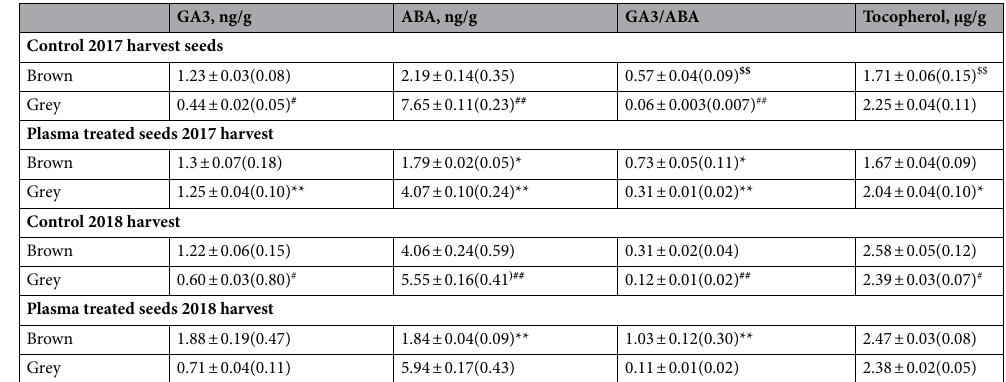
Table 1. The amount of GA3, ABA, GA3/ABA, and γ-tocopherol in control and plasma treated brown and grey radish sprout seeds harvested in 2017 and 2018. Results are presented as means ± SEM(SD), n = 6. *Statistically significant effect of CP (p < 0.05). **Statistically significant effect of plasma (p < 0.001). $ Statistically significant effect of harvest year for the same color (p < 0.05). $$ Statistically significant effect of harvest year for the same color (p < 0.001). # Statistically significant effect of color for the same harvest year(p < 0.05). ## Statistically significant effect of color for the same harvest year (p <